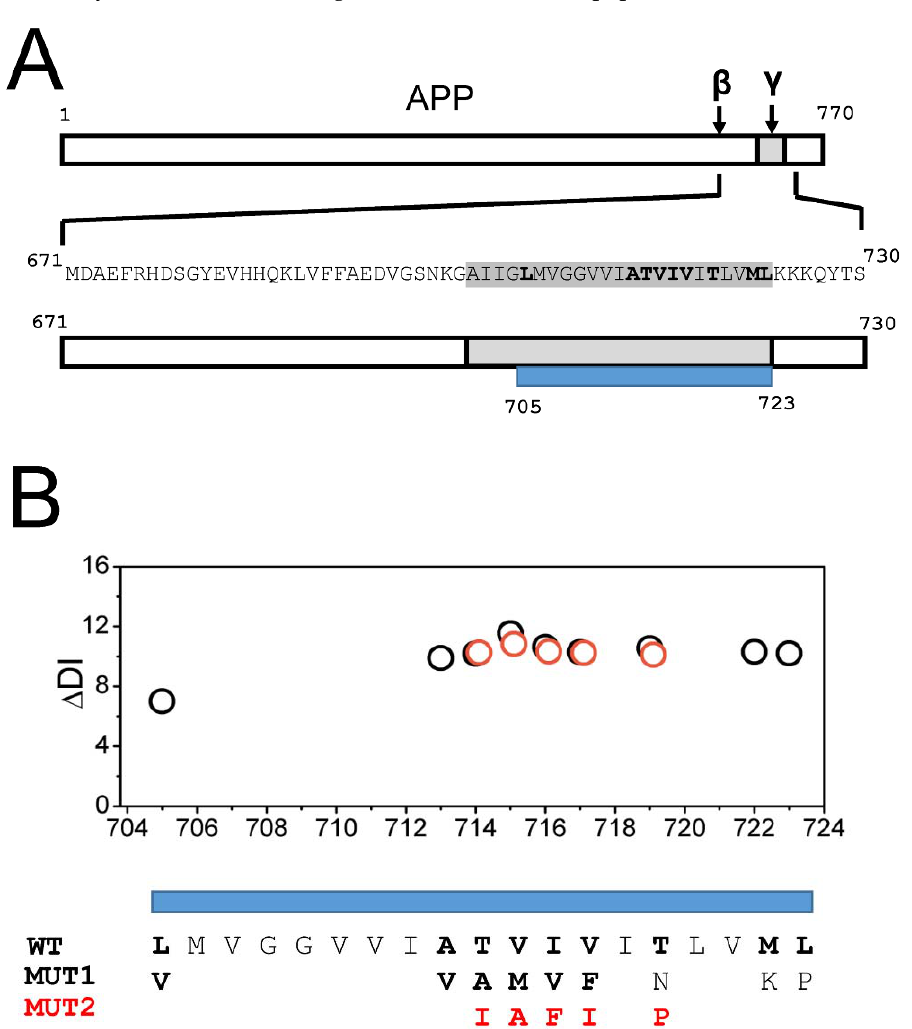
Figure 1. FAD mutations of the APP transmembrane domain destabilize the secondary structure. ( A ) Domain structure of APP, with locations of β - and γ -secretase cleavage sites, is indicated. The sequence of APP from the β -secretase cleavage site (M671) to the soluble region following the transmembrane domain (S730) is indicated. Transmembrane domain is shown in grey; positions that mutated in FAD are shown in bold font. Blue bar shows the boundaries of the mutated region. ( B ) Calculated difference in the disorder index ( ∆ DI) for FAD mutants is shown for MUT1 (open circles) and MUT2 (red circles)